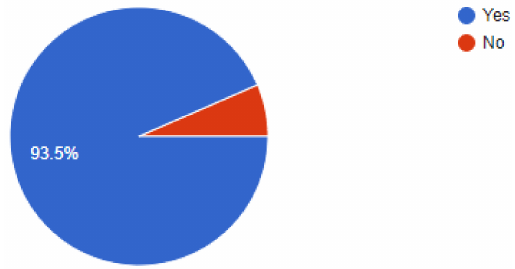
Figure 10. Have you added any measures for